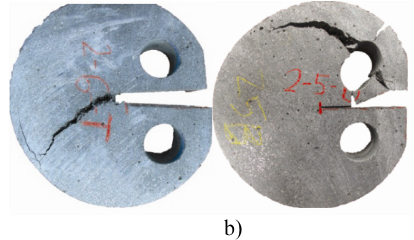
Fig. 5. Disc-Compact Tension Test (DCT): a) Proper DCT test; b) Failed DCT test